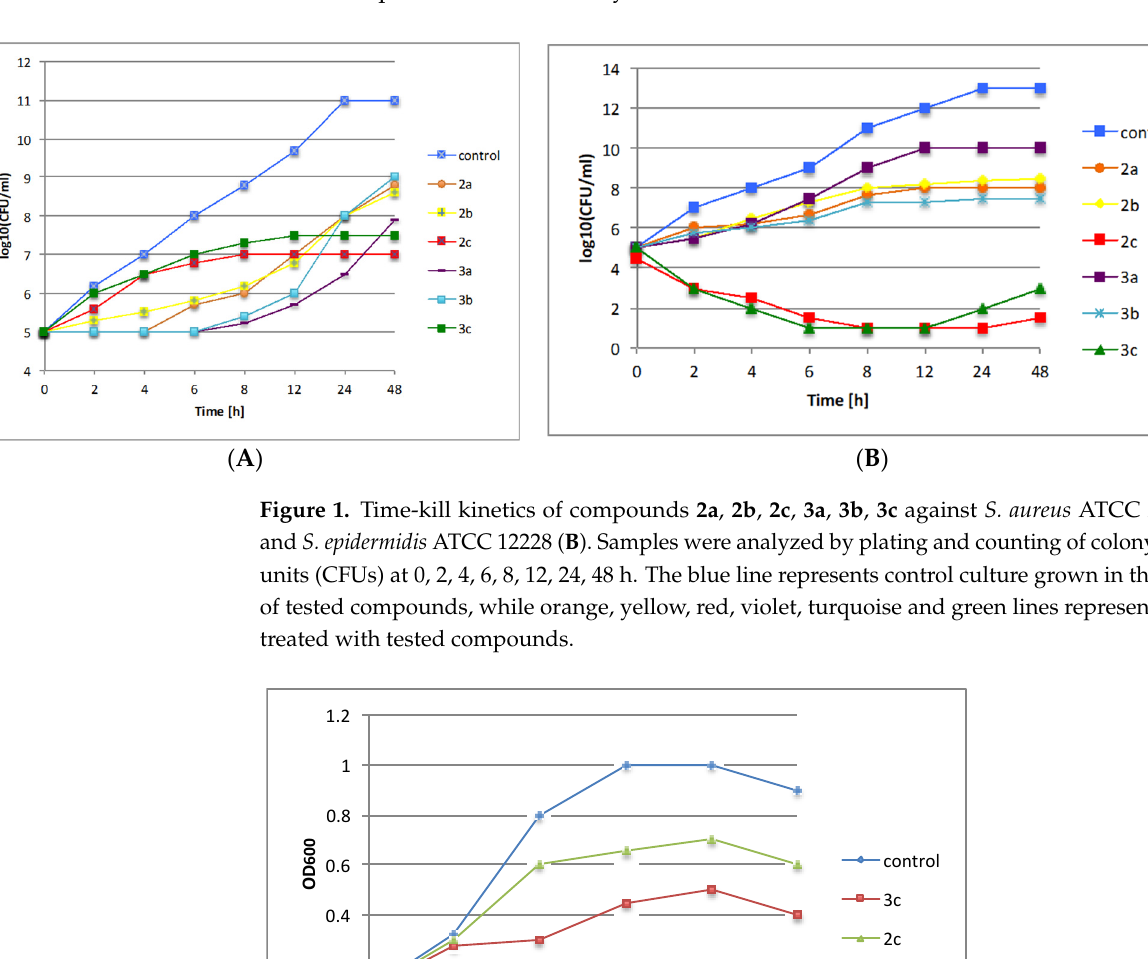
Figure 1. Time-kill kinetics of compounds 2a , 2b , 2c , 3a , 3b , 3c against S. aureus ATCC 29213 ( A ) and S. epidermidis ATCC 12228 ( B ). Samples were analyzed by plating and counting of colony-forming units (CFUs) at 0, 2, 4, 6, 8, 12, 24, 48 h. The blue line represents control culture grown in the absence of tested compounds, while orange, yellow, red, violet, turquoise and green lines represent cultures treated with tested compounds.